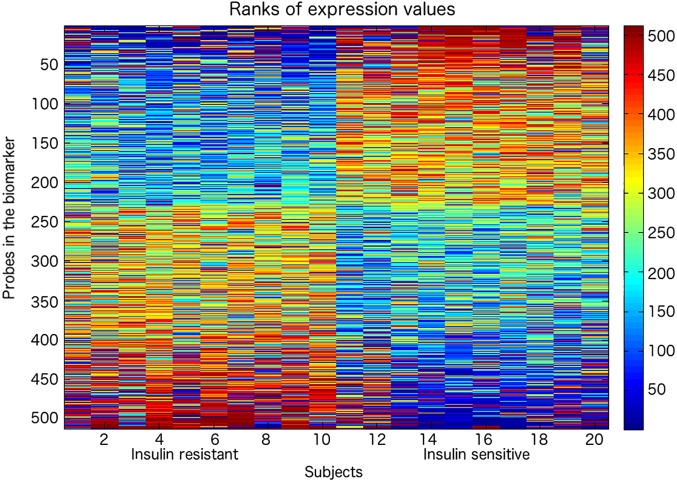
Heatmap of the 512 probes distinguishing IR and IS subjects.Rank values of the probes are represented and colors indicate the position of the probe expression level in the ranking of each sample (ascending order, red for over expressed probes, blue for under expressed probes). Each column reports the data of a single subject: 1 to 10 are the insulin resistant individuals, 11 to 20 are the insulin sensitive subjects. See also S2A Table.